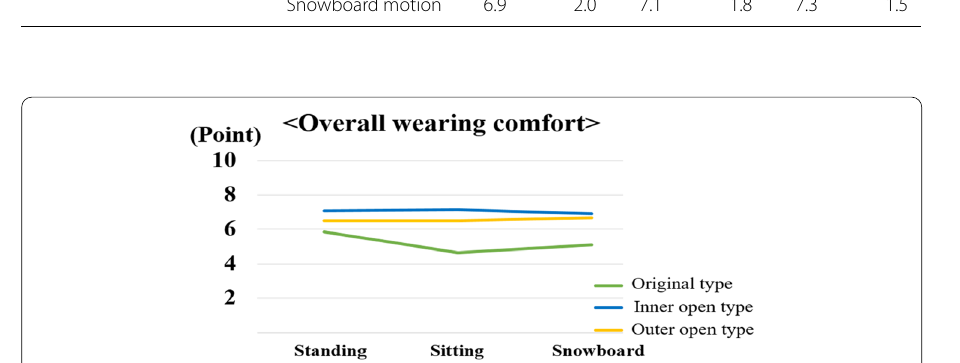
Fig. 6 Overall wearing comfort depending on shape and posture (Bonferroni post hoc analysis